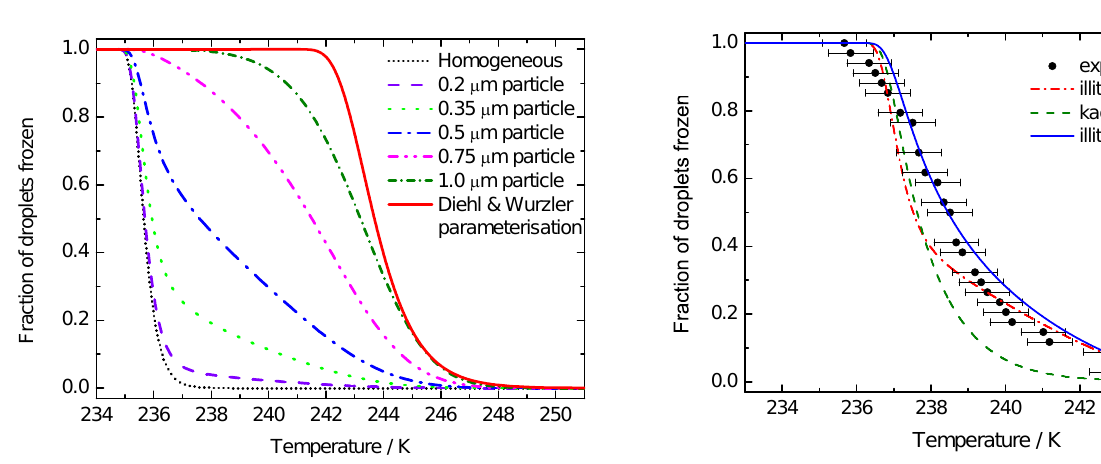
Fig. 16. Predicted fraction frozen curves for droplets containing mineral dust particles with a range of diameters. It is assumed that these particles are aggregates of smaller particles and have the same total surface area per mass as NX illite (104m 2 g − 1 ) with a density of 2.7gcm − 3 . The curves are calculated according to Eq. (21) for droplet diameters of 15µm. We also show the result of Diehl and Wurzler’s (2004) parameterisation for illite which is surface area independent.